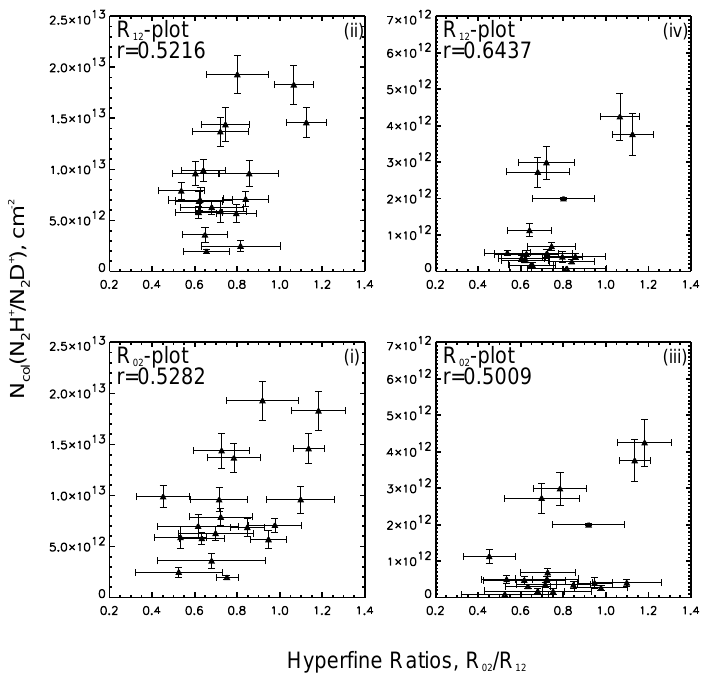
Fig. 5. Hyperfine ratios R 12 (top panel) and R 02 (bottom panel) versus N 2 H + and N 2 D + column densities (both J = 1 ! 0 transition). The correlation coefficients r are recorded in the